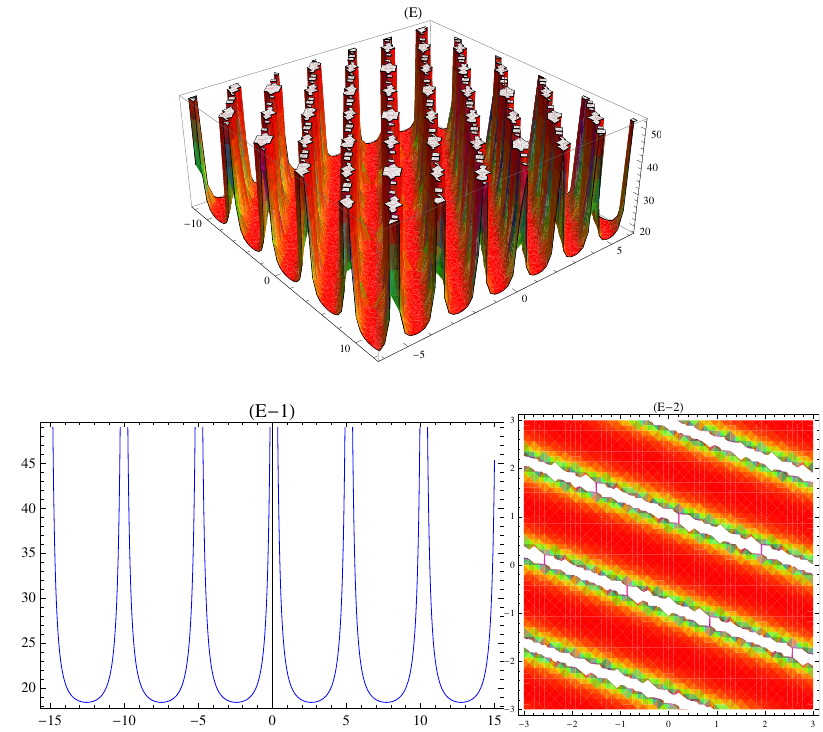
Figure 5: (E) 3D graph of (58) with θ = 2.3 , λ = 3.3 , µ = 1.8 , Θ = 1.5 , p = 0.98 , q = 0.95 , k = 2 , A = 2.6 , δ = −2 , ς = 2 , c = 2 , y = 2.7 , l = 1.5 . (E-1) 2D plot of (58) with t = 1 . (E-2) Contour graph of